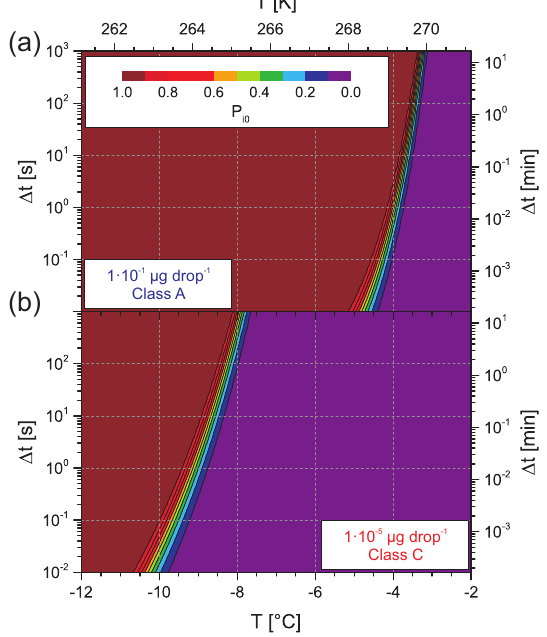
Figure A2. Contour plot of the nucleation probabilities P i 0 as a function of time and temperature for the parametrization using CNT and temperature-dependent contact angles shown in Fig. 6c for the two investigated concentrations of 1 × 10 − 1 µgdrop − 1 (a) and 1 × 10 − 5 µgdrop − 1 (b)